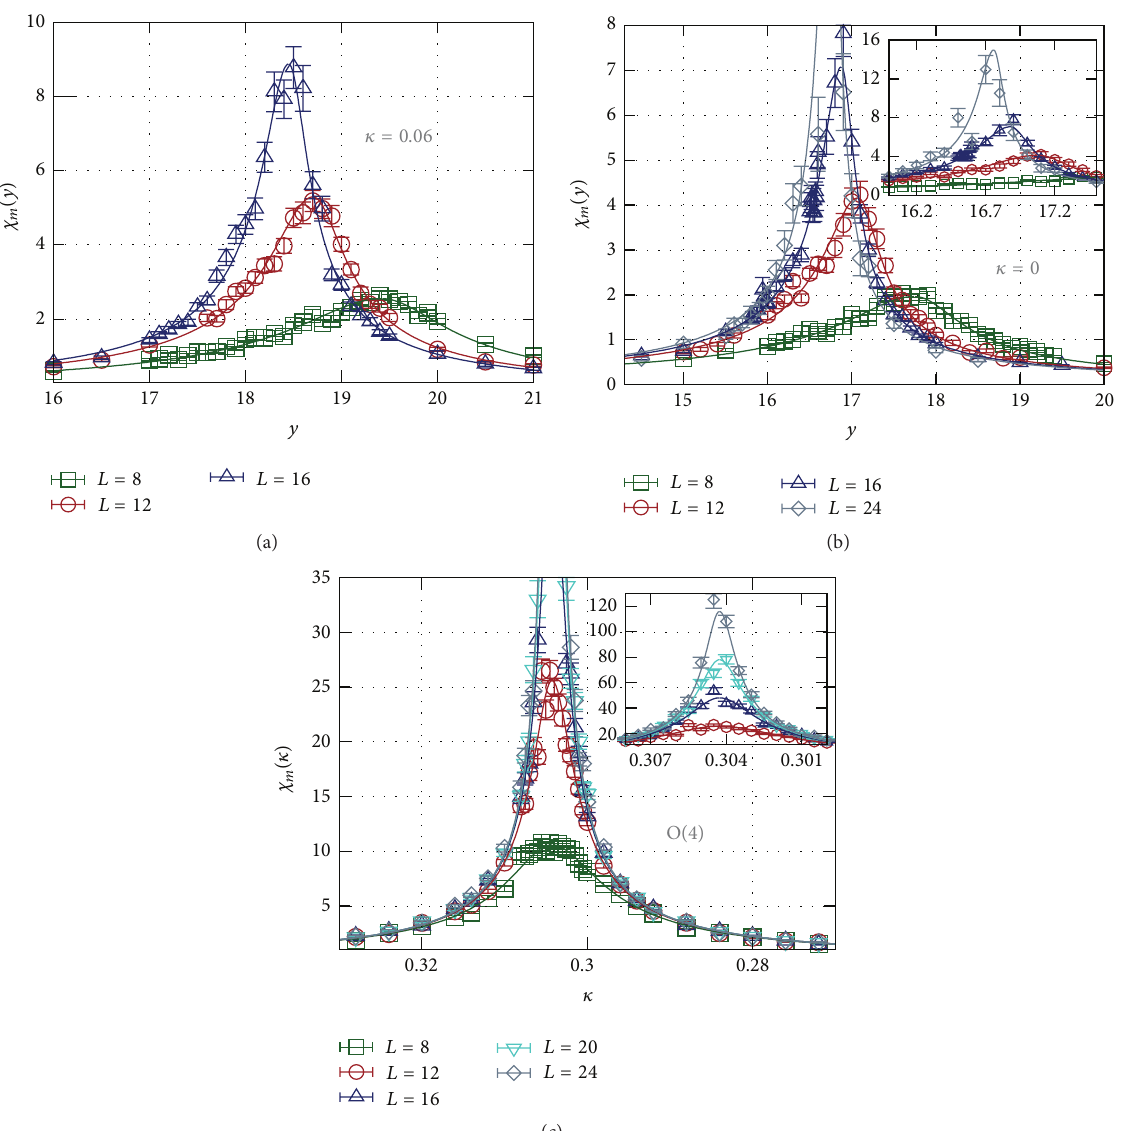
Figure 8: Susceptibility 𝜒 𝑚 at 𝜅 = 0.06 (a), 𝜅 = 0.00 (b), and the O(4) model (c) for various volumes. The curves are the result of a fit to (35). The right top boxes in (b) and (c) show 𝜒 𝑚 for the largest volumes. For the Higgs-Yukawa model, a volume-dependent shift of 𝑦 𝑐 towards 𝑦 (𝐿=∞) 𝑐 can be observed. This shift is not observed in the O(4)